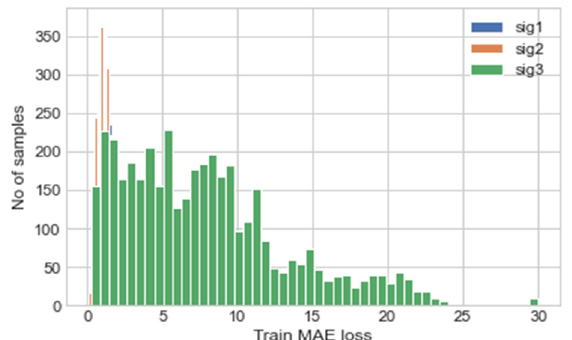
Figure 5. Histogram depicting MAE of each prediction for each input/output channel, where sig 1, sig 2 and sig 3 represent the right elevon, left elevon and motor power respectively.